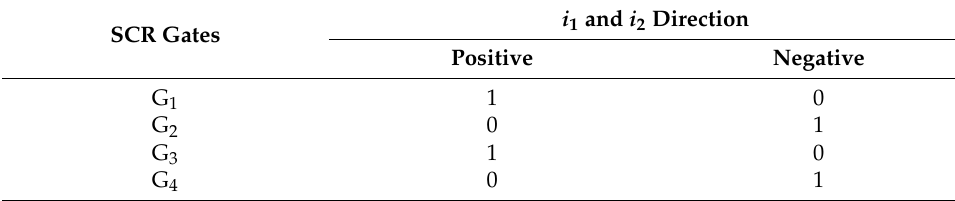
Figure 1. The proposed bi-directional Y-source coupled inductors DC circuit breaker. Table 1. Gate signals of the Silicon Control Rectifiers (SCRs).